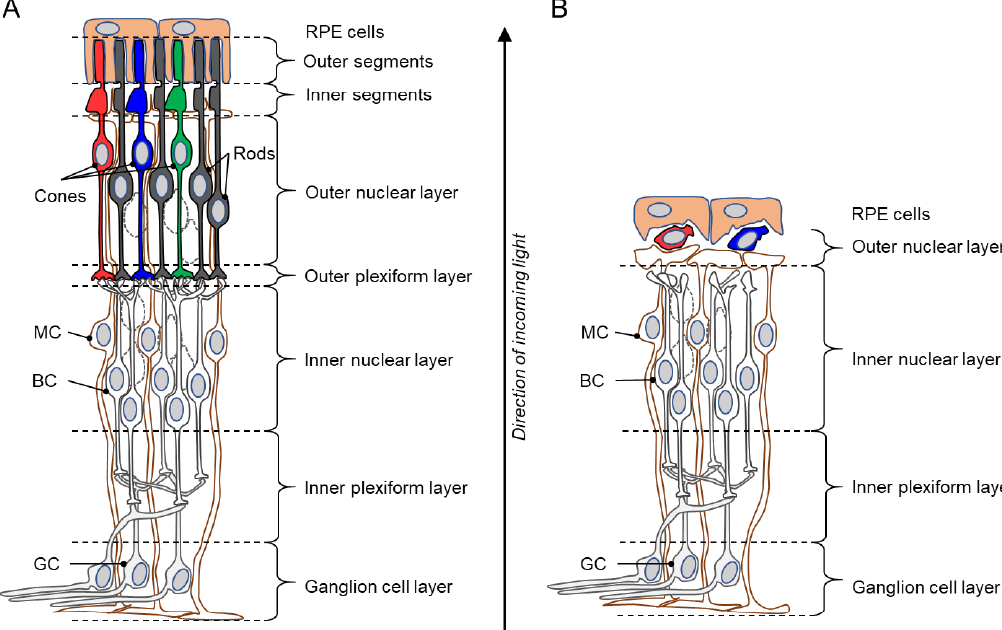
Figure 1. Schematic drawings of a healthy retina and a inherited retinal degeneration (IRD) retina. ( A ) Illustration of the various layers of an intact, healthy retina, from the retinal pigment epithelium (RPE) to the ganglion cell layer. Rod photoreceptors in the outer retina are shown in black, while cones are indicated by red, green, and blue. ( B ) Degenerated IRD retina. The outer nuclear layer is almost completely lost and the outer plexiform layer has essentially disappeared. Curiously, when the retina has lost all functionality, a small number of cone photoreceptors may still be present, possibly for many years beyond the loss of rod photoreceptors. BC = bipolar cell; GC = ganglion cell; MC = Müller glial cell. Note that the retinal structure has been simplified for clarity and that not all retinal cell types are shown.